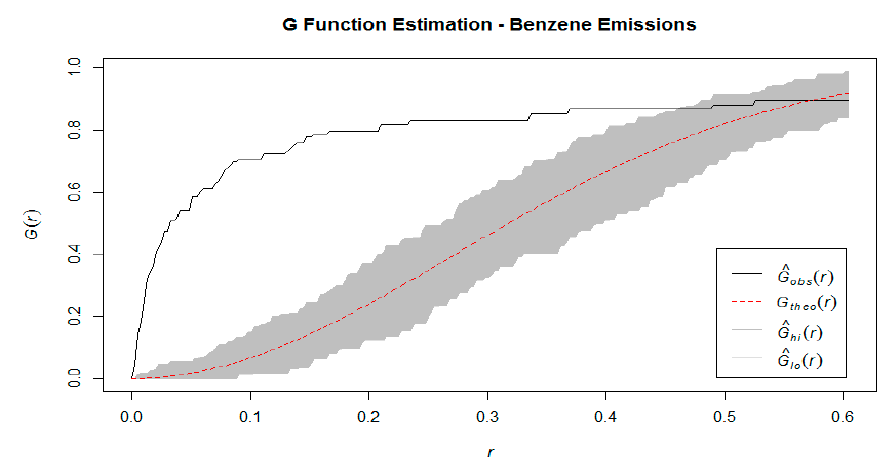
Figure 5. G Function estimation benzene emission sites.